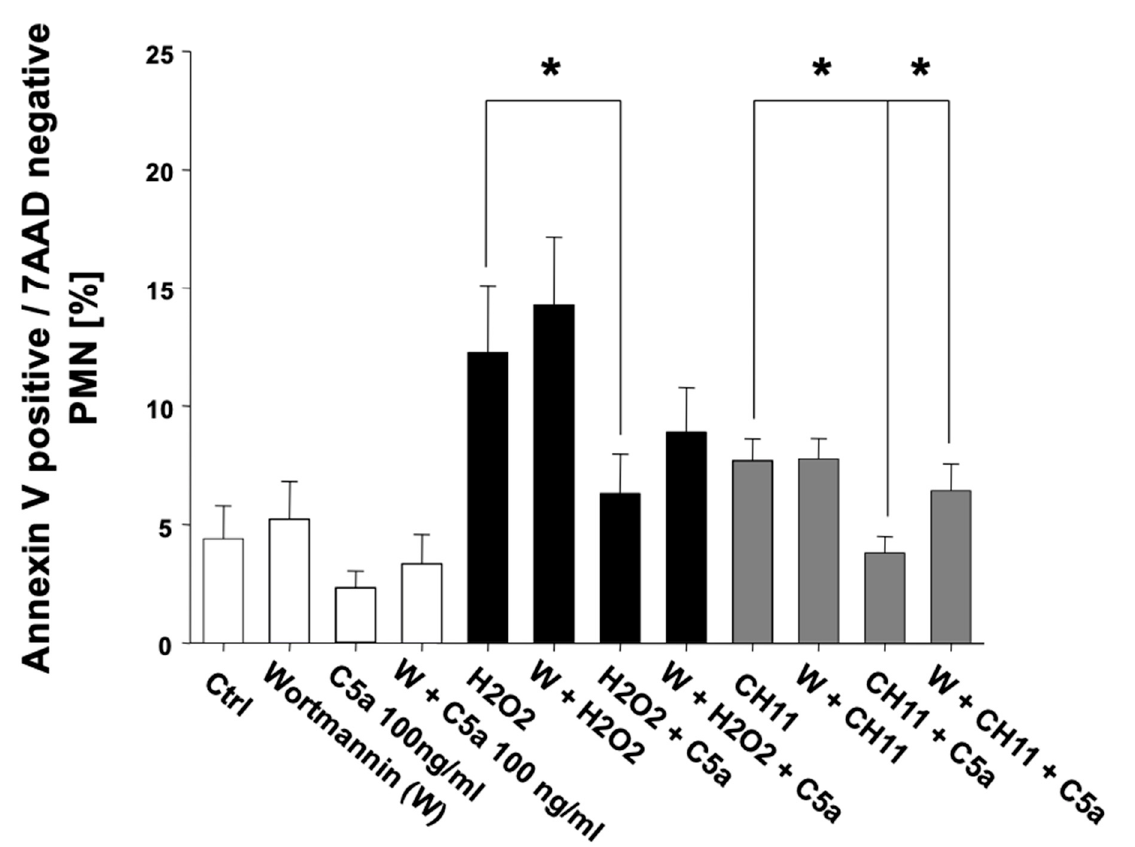
Figure 6. Inhibition of PI3-kinase by wortmannin (W) results in a partial reversal of the C5a-caused reduction of PMN apoptosis. Comparison of the apoptosis rate of freshly isolated PMN from healthy male volunteers ( n = 5) in percent under influence of C5a and W before (transparent) as well as after induction of intrinsic, H 2 O 2 -induced (black) as well as extrinsic, CH11-induced apoptosis (gray). The percentage of apoptotic PMN was determined by Annexin-V/7-AAD staining and flow cytometry. Results are shown as mean ± SEM. * = p < 0.05.